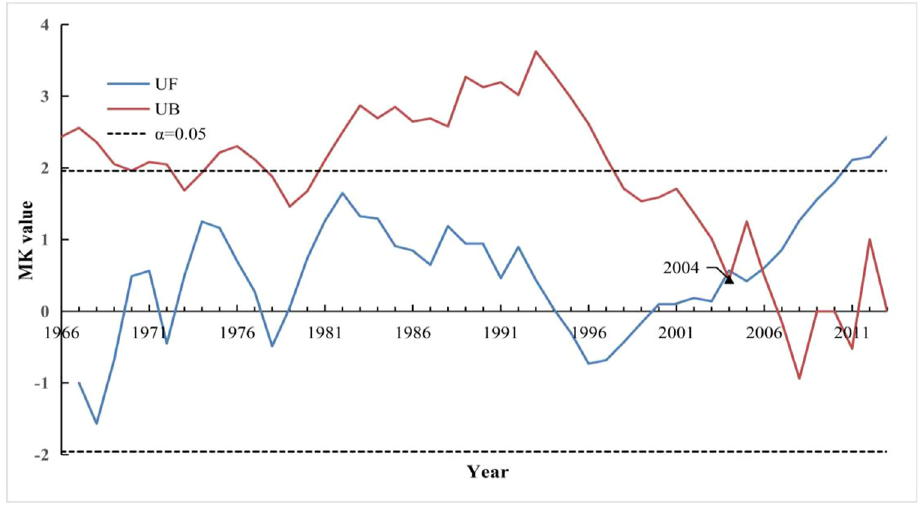
Figure 4. Mann-Kendall (MK) test of annual runoff depth from 1966 to 2013 in the YRHA.